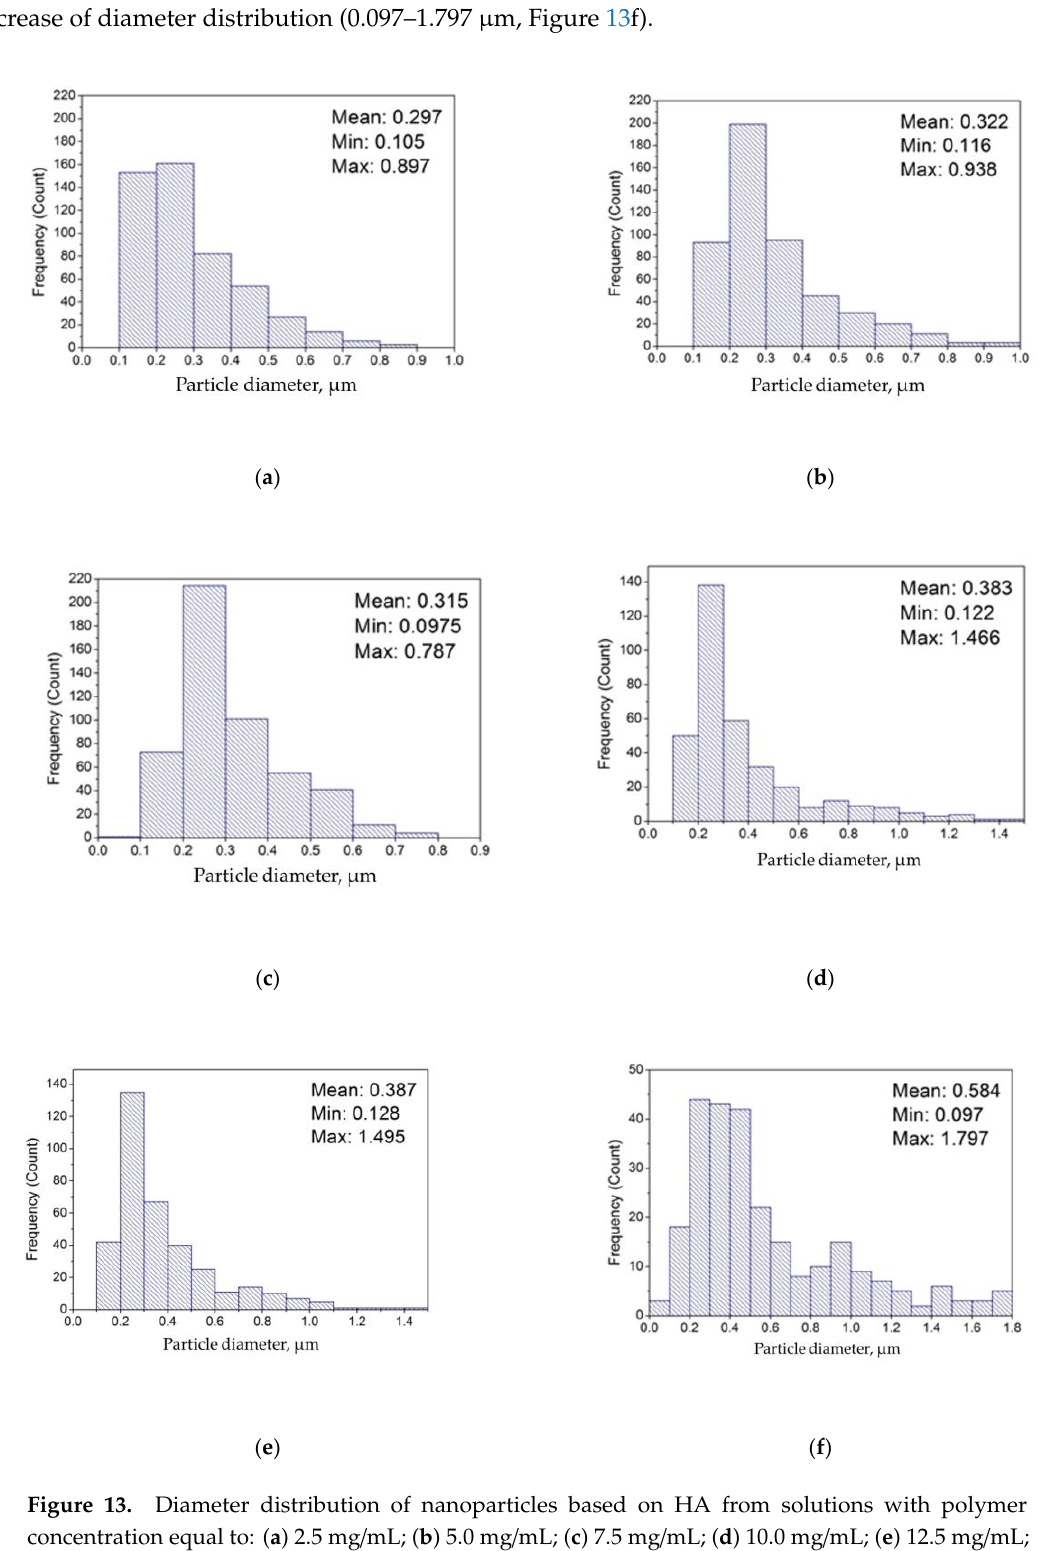
Figure 13. Diameter distribution of nanoparticles based on HA from solutions with polymer concentration equal to: ( a ) 2.5 mg/mL; ( b ) 5.0 mg/mL; ( c ) 7.5 mg/mL; ( d ) 10.0 mg/mL; ( e ) 12.5 mg/mL; ( f ) 15.0 mg/mL.